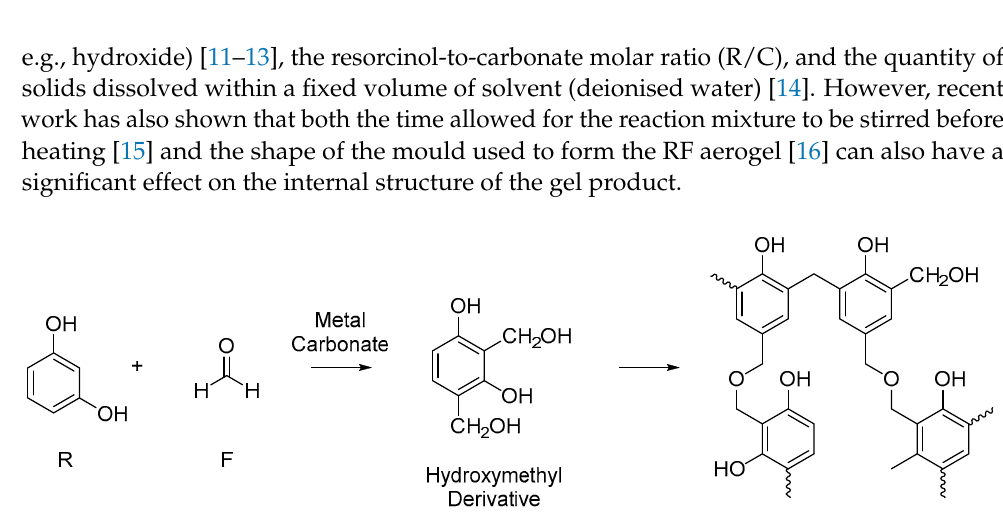
Figure 1. General reaction scheme in the formation of resorcinol–formaldehyde gel.